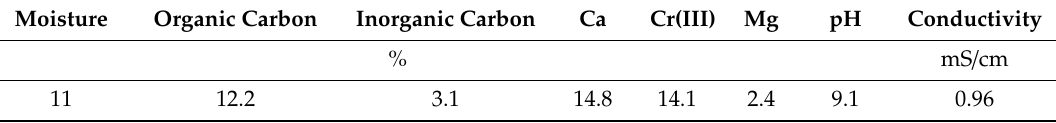
Table 1. The main components and physicochemical parameters of tannery sludge